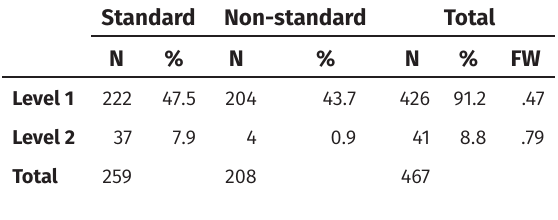
Table 7: Use of standard and non-standard variants depending on the complexity of the